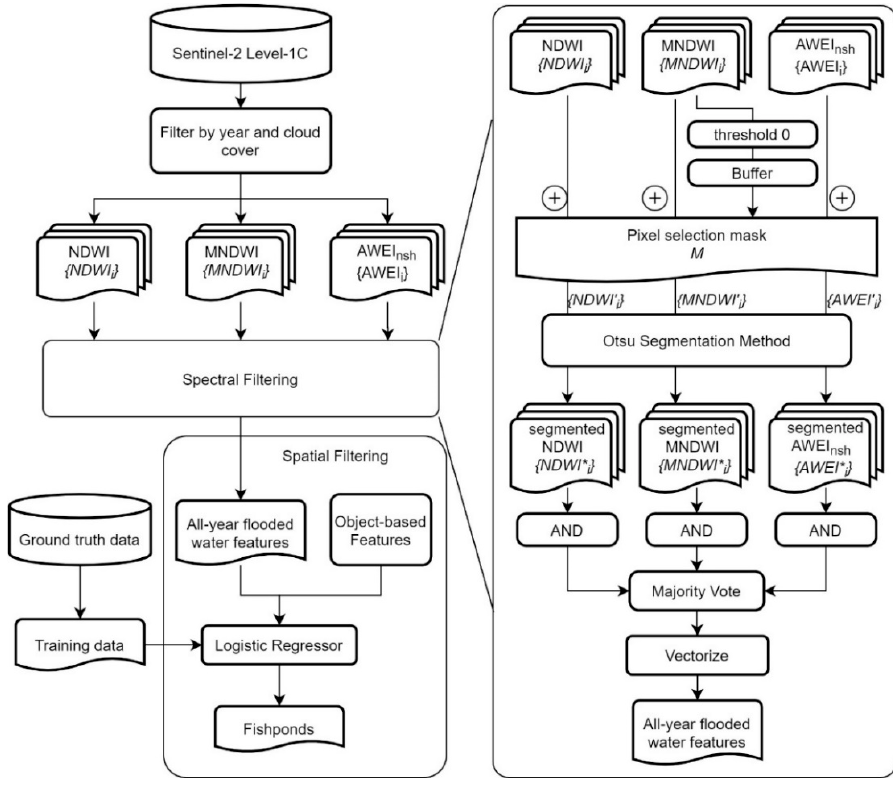
Figure 2. Proposed workflow. Table 2. Equations of the three water indexes (WIs) used in this study. ρ in the equations represents Top-of-Atmosphere (TOA) reflectance of corresponding Sentinel-2 bands, e.g., ρ NIR is the TOA value of Sentinel-2 near-infrared